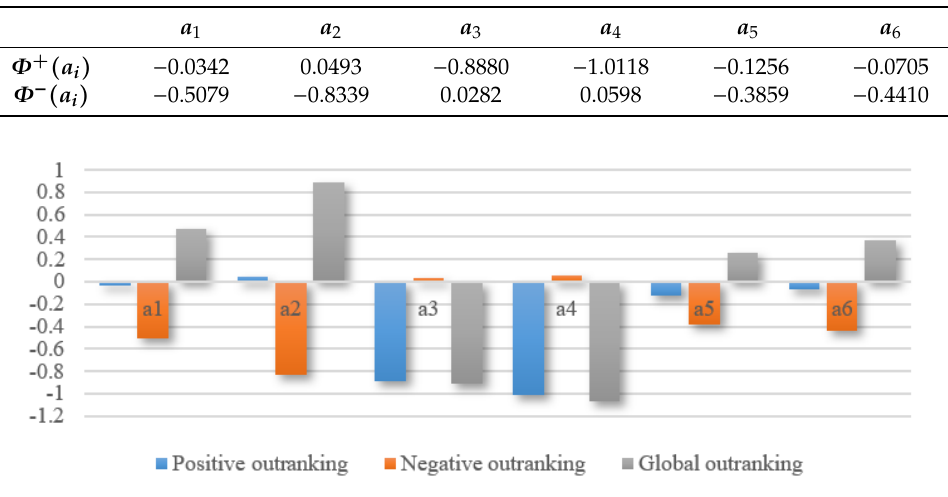
Table 3. The positive and negative outranking flows.